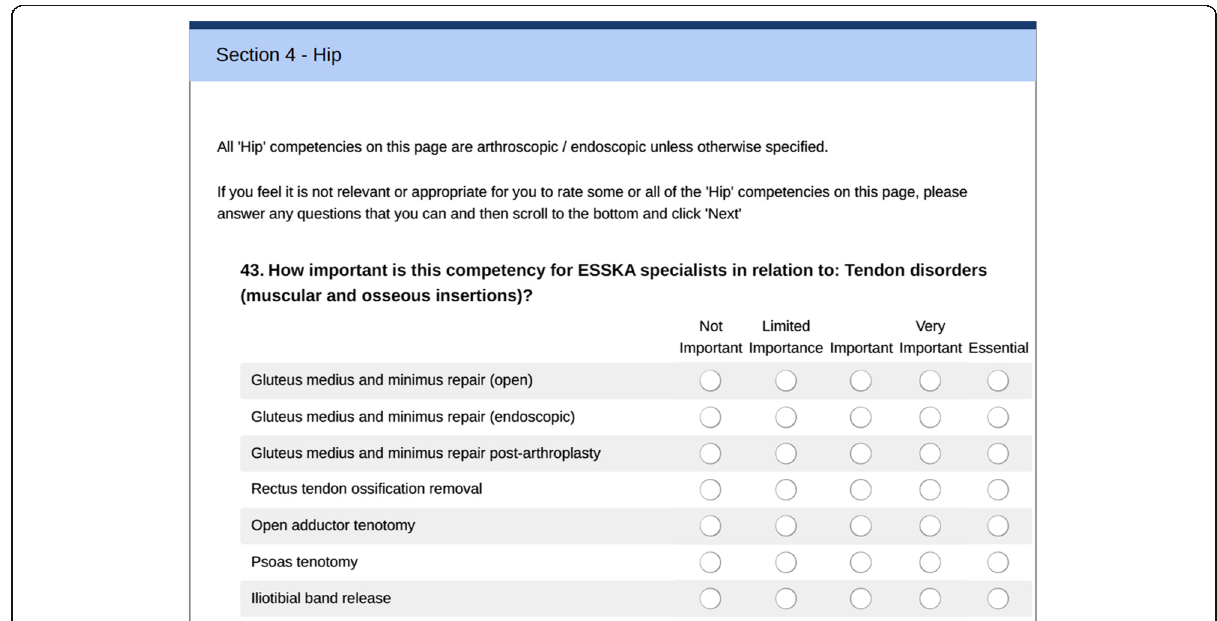
Fig. 1 Example screenshot from online